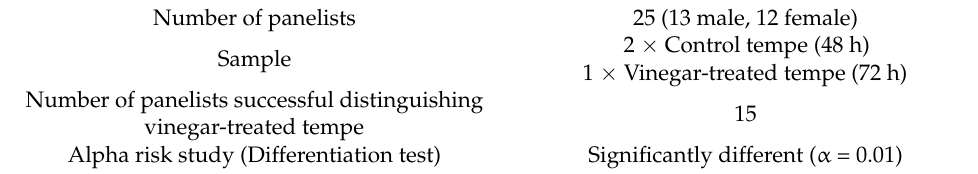
Table 1. Details and results of triangle test.